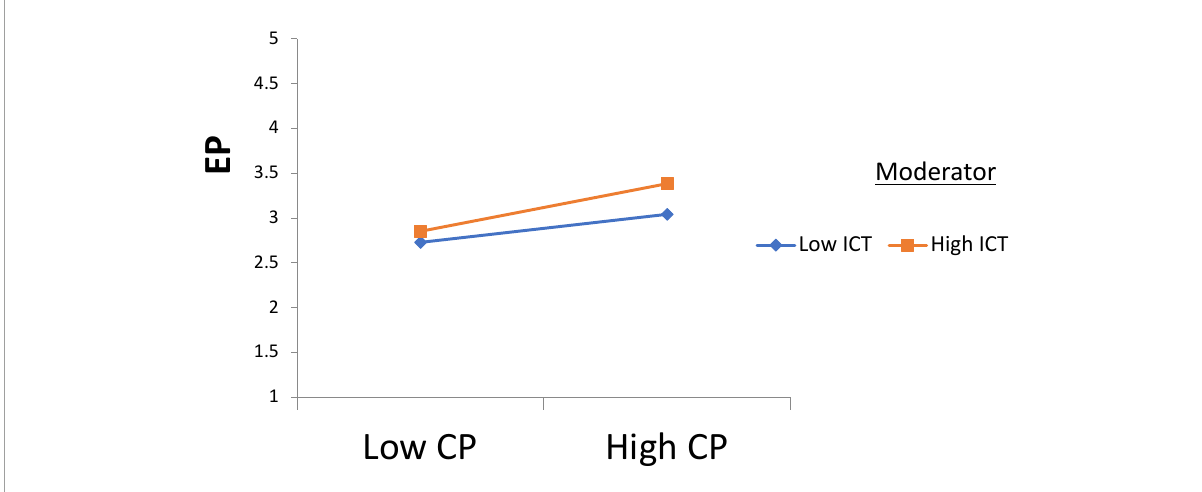
FIGURE7 Moderation effect 5. CP, Commercialization Performance; ICT, Information Communication Technology; EP, Entrepreneurial